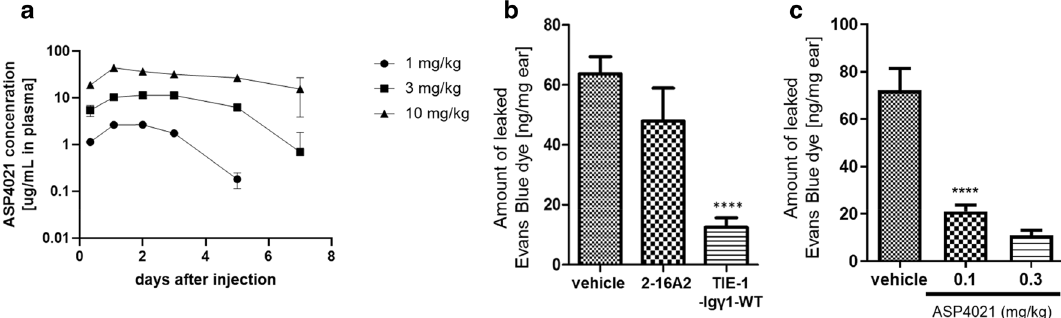
Figure 3. Effect of ASP4021 and related antibodies on vascular permeability in vivo. ( a ) Pharmacokinetics analysis of ASP4021 in rats. The concentration of ASP4021 in rat plasma after subcutaneous administration was measured using an ELISA-based assay. Each value indicates the mean ± SD of 3 rats per group. ( b ) Inhibitory effect of 2-16A2 and TIE-1-Igγ1-WT on vascular permeability in a rat mustard oil-induced vascular permeability model following treatment with 0.3 mg/kg. The vertical axis indicates the amount of leaked Evans Blue dye. The graph indicates the mean ± SEM of 6 rats per group. Student’s t-test was employed for statistical analysis. **** p < 0.0001 vs the vehicle group. ( c ) Inhibitory effect of ASP4021 on vascular permeability in a rat mustard oil-induced vascular permeability model following treatment with 0.1 or 0.3 mg/kg. Each